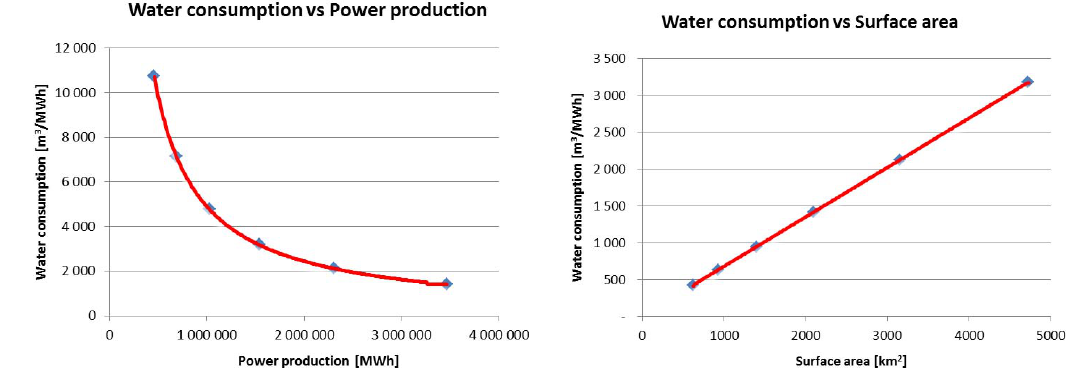
Fig. 5. The graphs present estimated water consumption from the planned Beles Hydroelectric Power Plant in Ethiopia (black rings on the graph) with use of Lake Tana as the reservoir (Tefferi, 2012), and illustrates also how the water consumption will vary with power production (left panel) and surface area (right